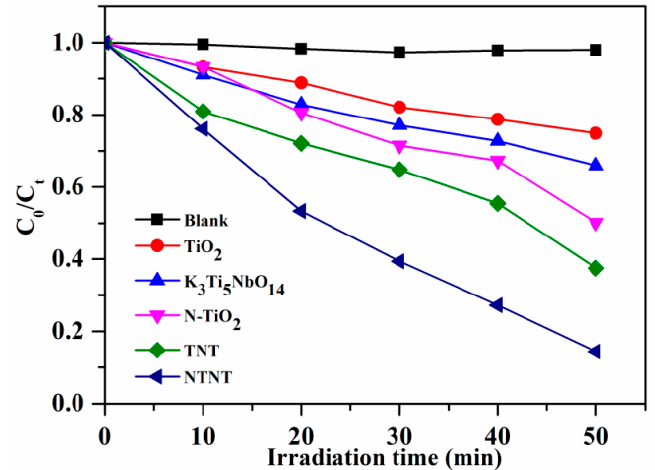
Figure 6. Visible light photocatalytic degradation rate of methylene blue (MB) solution for different samples